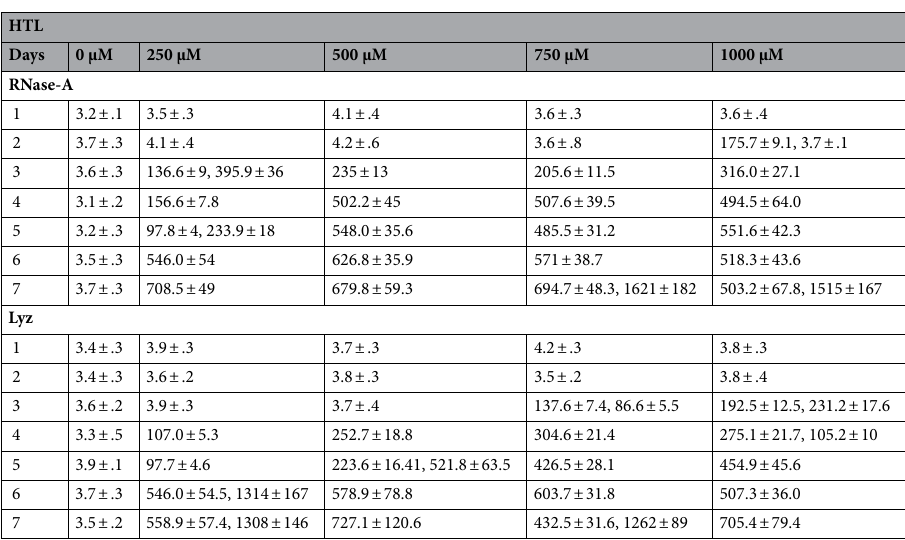
Table 2. Hydrodynamic diameter of HTL-modified protein samples: Hydrodynamic diameter (in nm) of RNase-A and Lyz modified with 250 µM, 500 µM, 750 µM, and 1000 µM HTL at 24 h intervals up to 7 days measured using